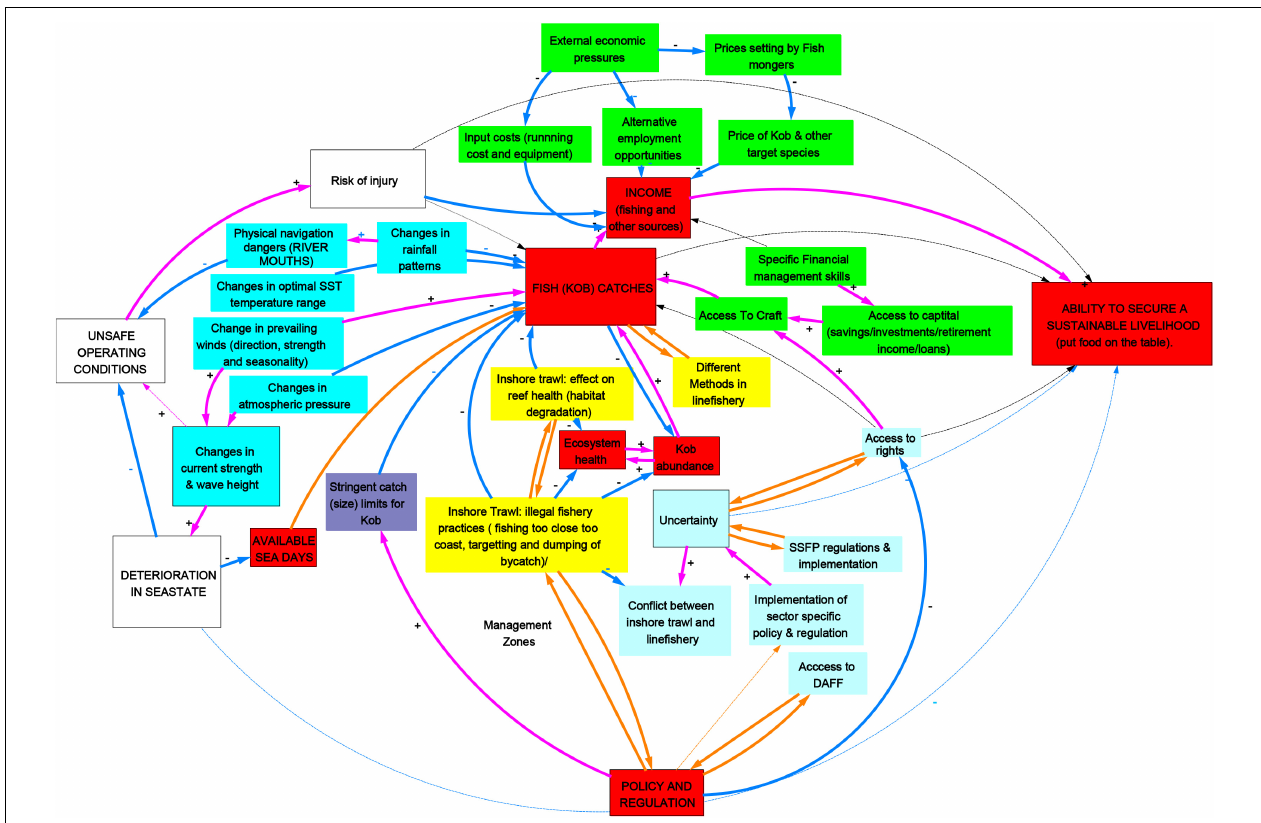
Table 1 for colour